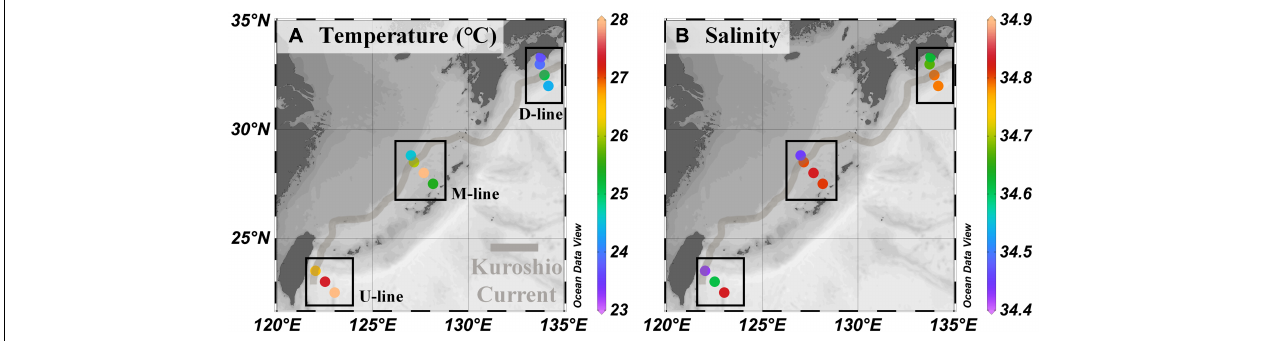
FIGURE 2 | Environmental variables in the Kuroshio region observed during the KH-15-4 cruise. (A) Temperature, (B) Salinity. The location of the Kuroshio Current during the cruise and transect lines are shown as in Figure 1 . Values for each parameter are shown in Table 2 .